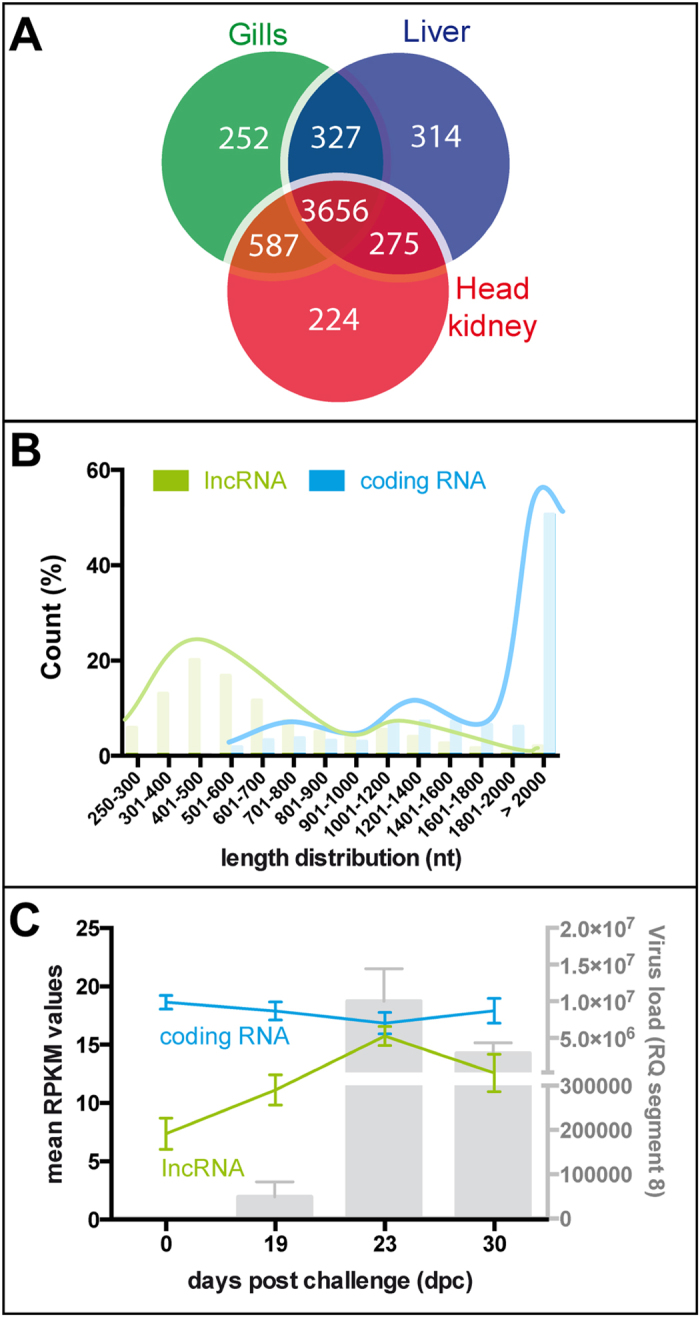
Features of predicted novel lncRNAs.(A) Venn diagram on the distribution of 5,636 putative lncRNAs across three tissues. The overlapping expression profiles of predicted long non-coding RNA transcripts from each tissue are depicted in different colors: gills (Green), liver (Blue), and head-kidney (Red). (B) Length distribution of 5,636 predicted novel lncRNAs and 19,846 coding transcripts. (C) RPKM distribution of maximum expression levels for lncRNAs and mRNAs across the three tissues, based on RNA-Seq data.